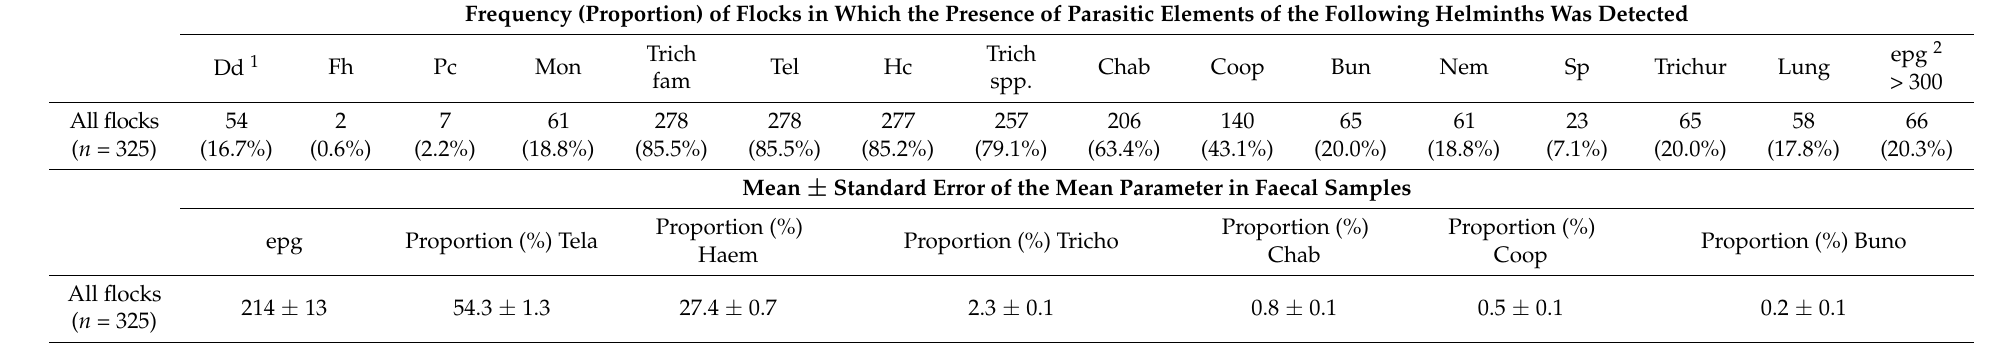
Table 1. The cumulative results of parasitological examinations in pooled faecal samples from 325 sheep flocks in a countrywide investigation in Greece. Frequency (Proportion) of Flocks in Which the Presence of Parasitic Elements of the Following Helminths Was Detected